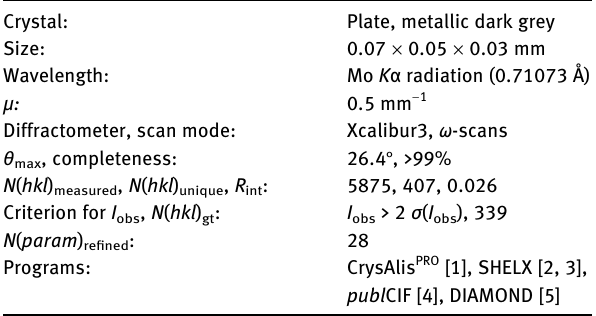
Table 1 contains crystallographic data and Table 2 contains the list of the atoms including atomic coordinates and displacement parameters.